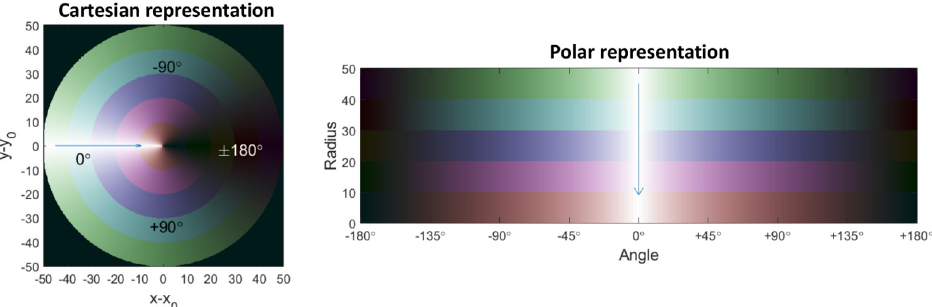
Fig 4. A non-Cartesian way to visualise the impact of the mimicked tumour-generated strain around the inflated balloon. Left: example of Cartesian representation of the inclusion where circular regions at different radial distances from the centre of the inclusion are showed with different colours. Right: a better visualisation, independent on the mean direction of propagation of the waves, is obtained through the unravelling of the image following the perimeter of each circular